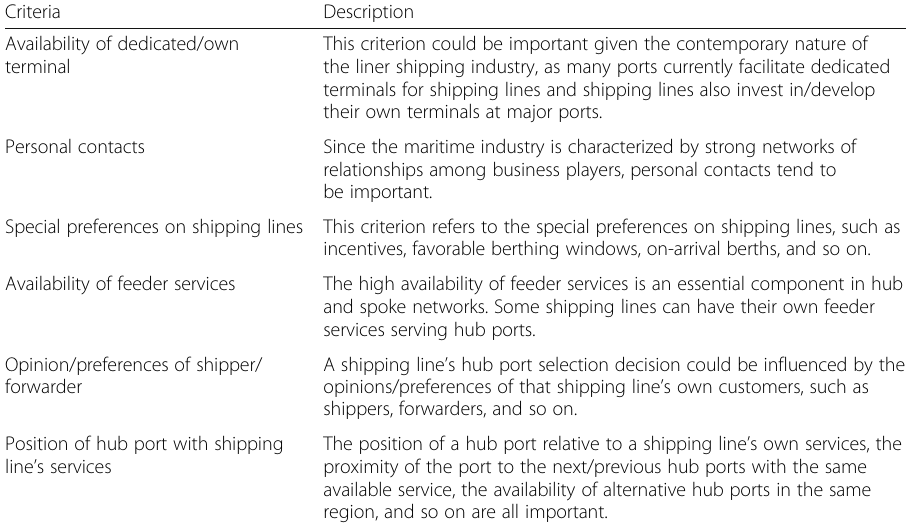
Table 7 Criteria Related to the Liner-Related